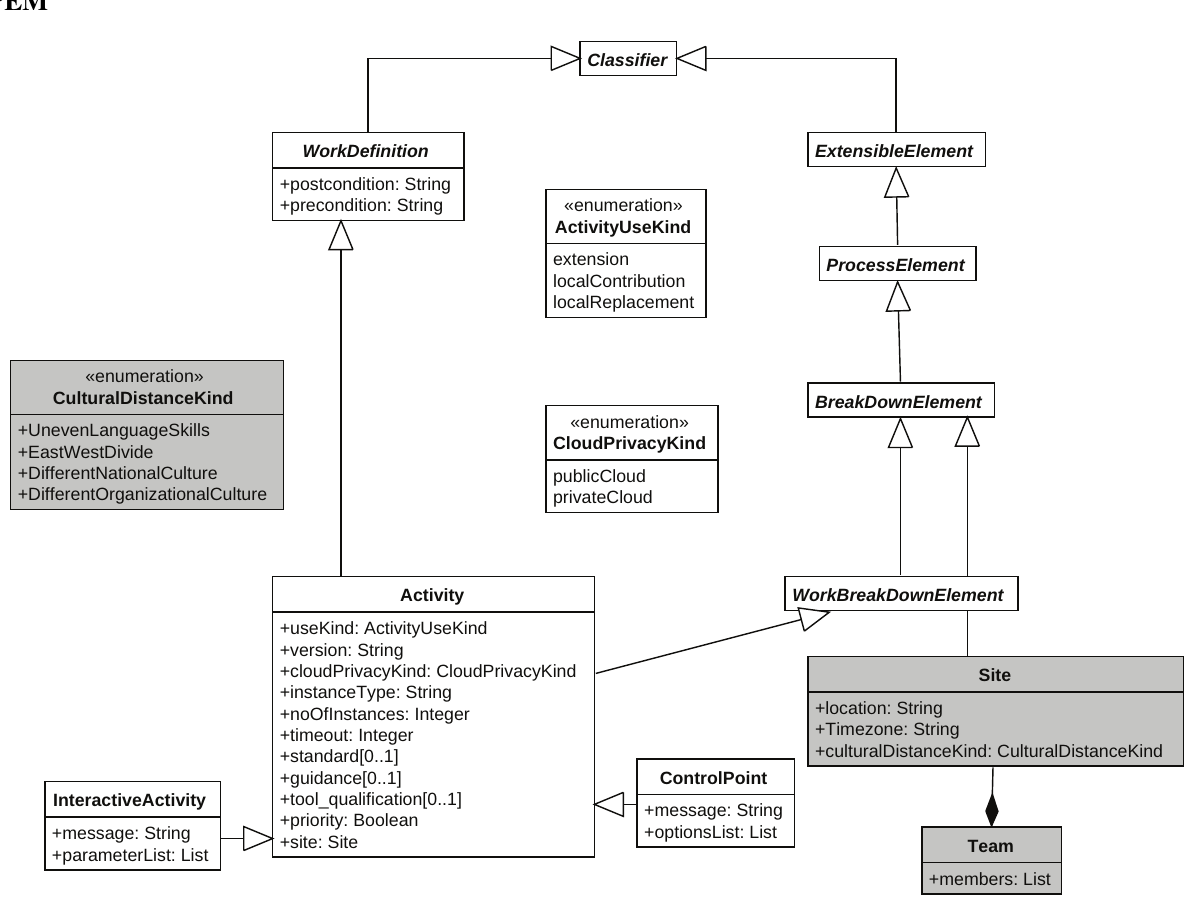
Figure B.1: The extended meta-model of EXE-